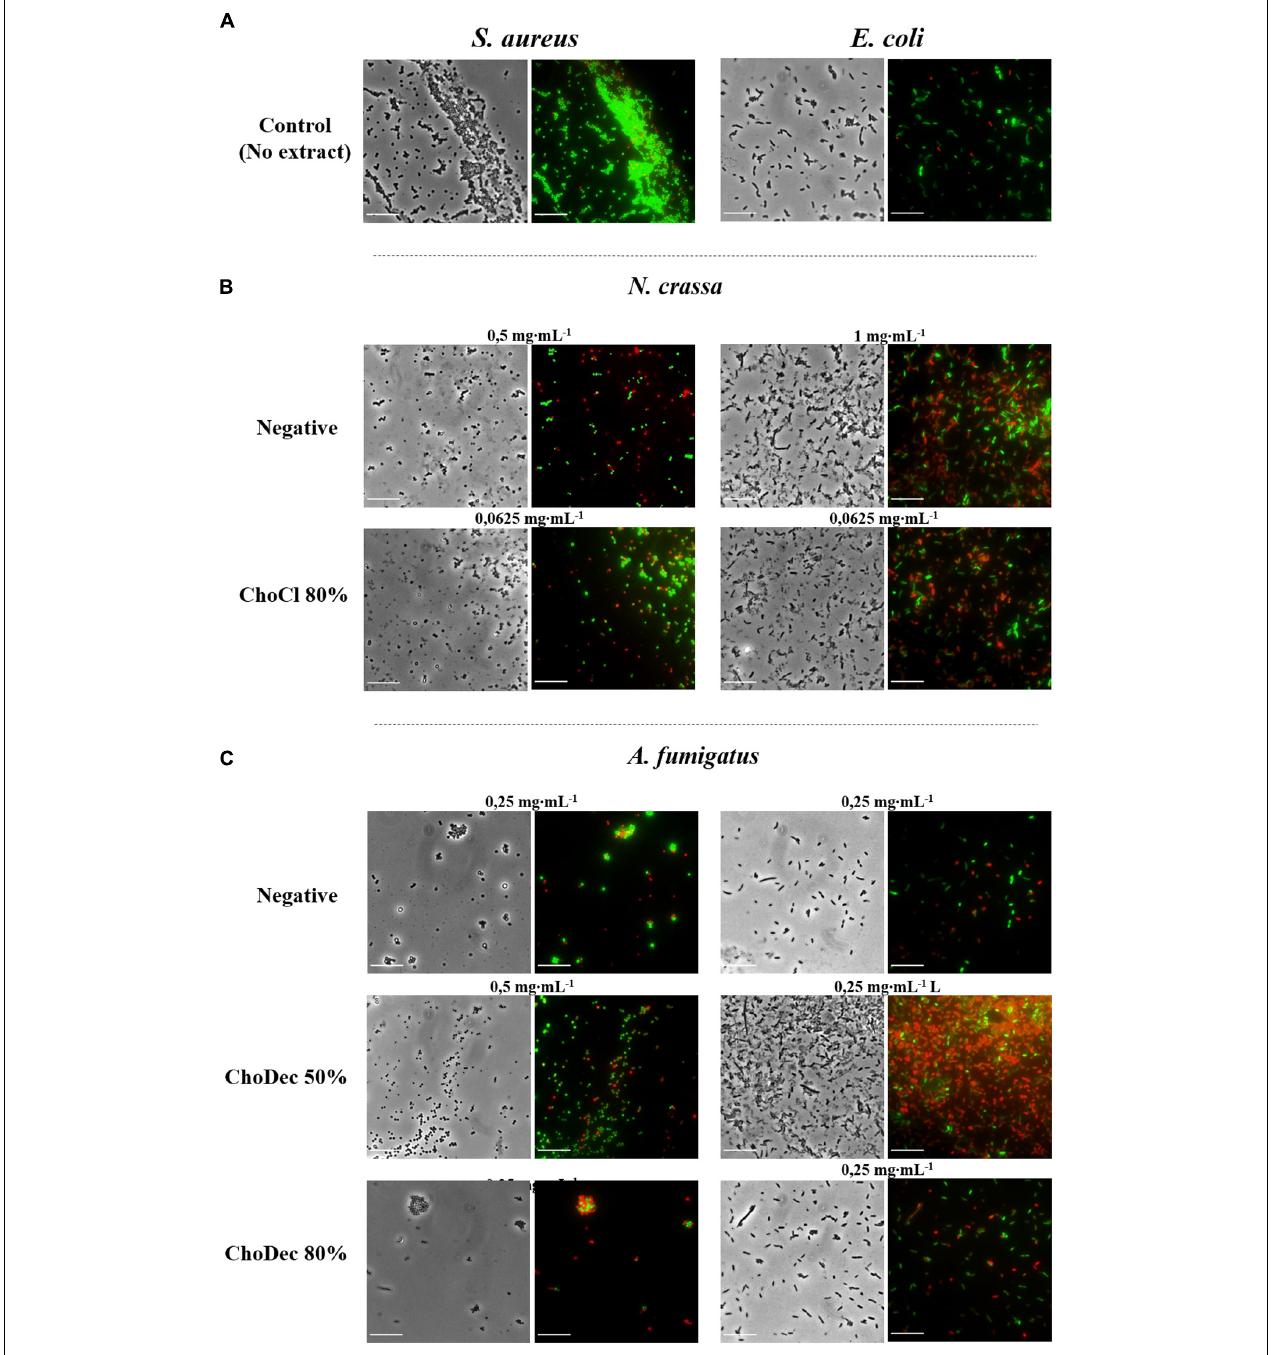
FIGURE 4 | N. crassa and A. fumigatus crude extracts led to significant lysis of S. aureus and E. coli cells, which is denoted by the red labeling. Microscopic snapshots of E. coli and S. aureus grown in the absence of extract (A) and in the presence of crude extracts derived from cultures grown in media with or without ( i.e., negative) supplementation: N. crassa (B) and A. fumigatus (C) . Images of bacteria at concentrations near the measured IC 50 for each crude extract are shown. Cells were stained with SYTO9 (green) and PI (red) denoting live and dead cells, respectively. Scale bar, 10 µ